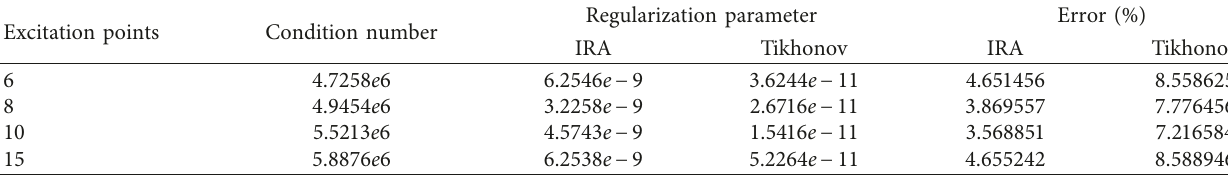
Table 5: Comparisons of the IRA with the Tikhonov regularization for the identified impact load errors under differential exciting points. Excitation points